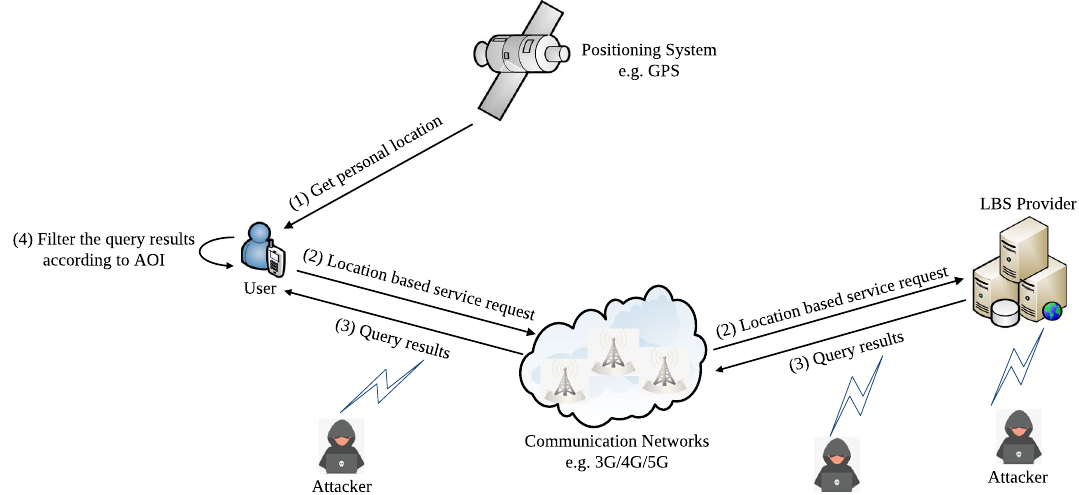
Figure 3. A simple framework of the LBS